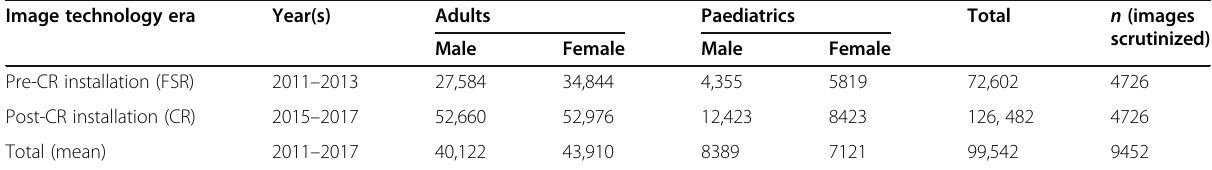
Table 1 Average annual population of x-ray images and sample size for the study Image technology era